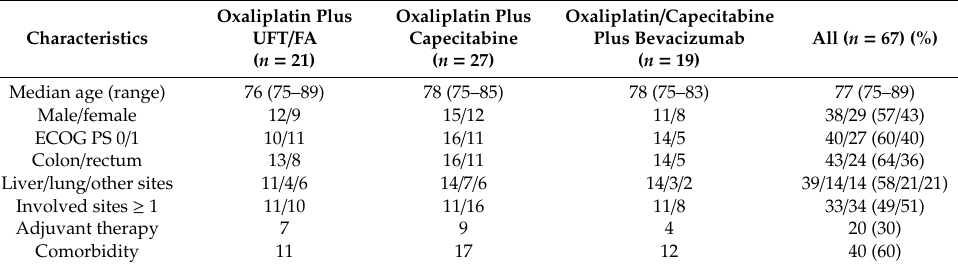
Table 1. Patient distribution, ≥ 75 years.